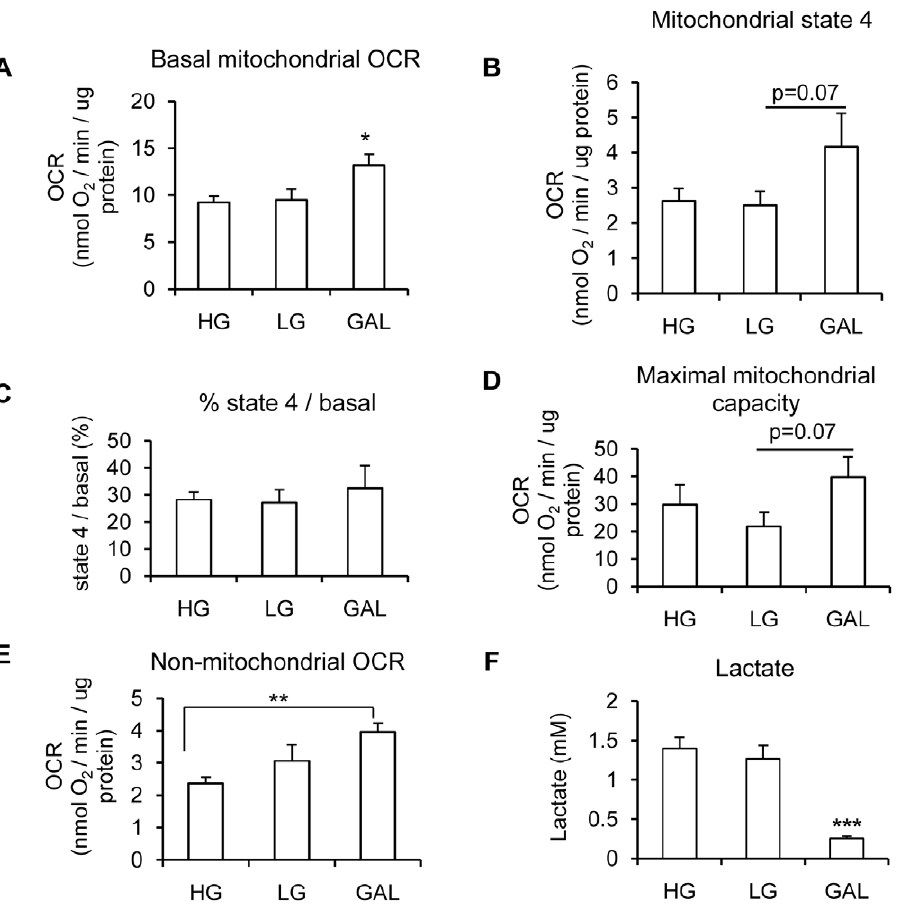
Figure 2. Effect of replacing a glucose medium with a galactose medium on myotube aerobic capacity. A. Basal mitochondrial oxygen consumption rate. *, p , 0.05, GAL vs HG and LG. B. State 4 respiration (leak-dependent; non-phosphorylating). After basal oxygen consumption rate measurement, cells were treated with oligomycin (600 ng/ml) to determine state 4 respiration. p=0.06, GAL vs LG. C. Percentage of basal OCR due to proton leak was calculated from the data shown in Figure 2A and B. Data are presented as means 6 SEM, n=7, in which each condition was assessed in 5–6 replicates. D. Maximal mitochondrial oxygen consumption capacity. After basal and state 4 respiration measurements, cells were treated with FCCP (1 m M) to determine maximal oxygen consumption. *, p , 0.05, GAL vs LG. E. Non-mitochondrial oxygen consumption rate. After basal, state and maximal respiration measurements, cells were treated with antimycin (4 m M) to determine non-mitochondrial oxygen consumption. **, p , 0.01, GAL vs LG. F. Lactate concentration in the extracellular media of myotubes differentiated for 7 days in HG (25 mM glucose), LG (5 mM glucose) or GAL (10 mM galactose). Results are presented as means 6 SEM, n=7, in which each condition was assessed in duplicate. ***, p , 0.0001, GAL vs HG and